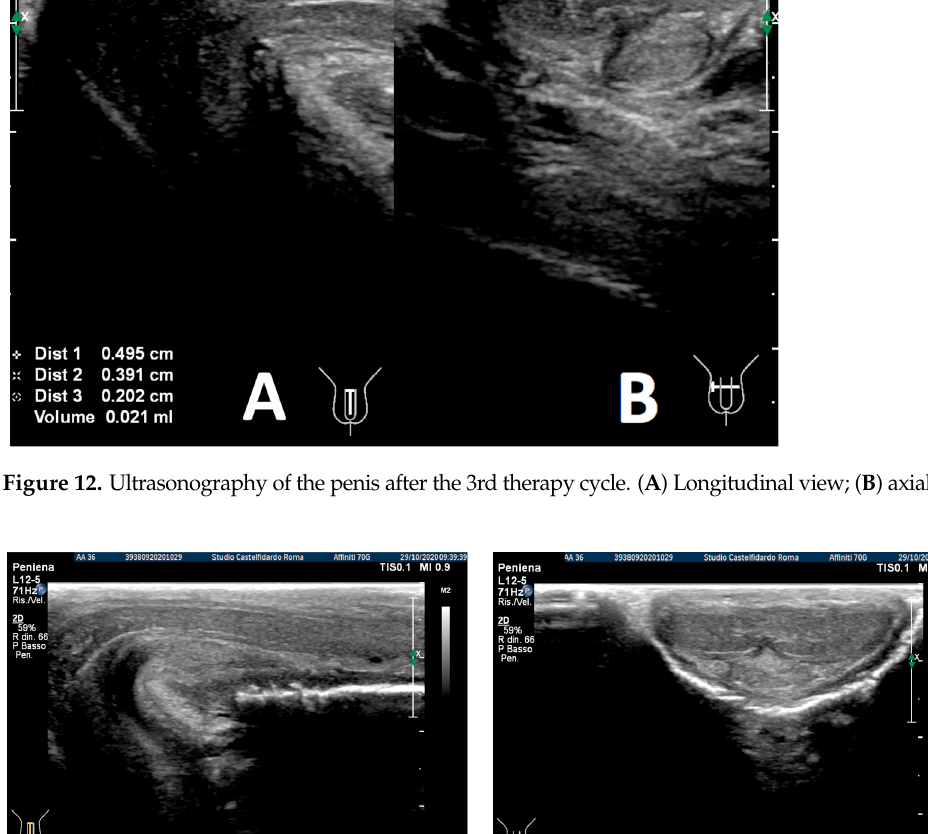
Figure 13. Ultrasonography of the penis after the 3rd therapy cycle. ( A ) Longitudinal view; ( B ) axial view.